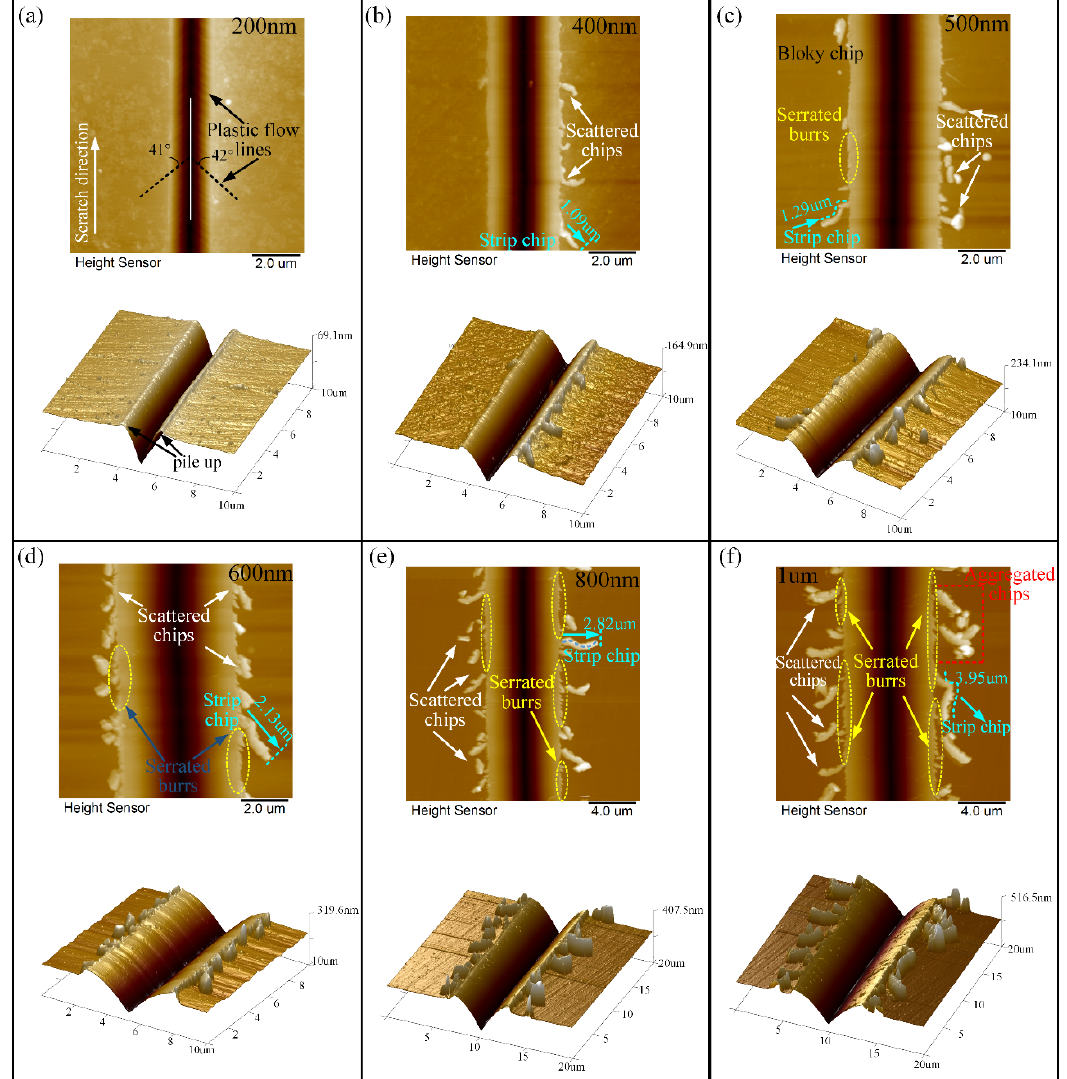
Figure 8. Surface deformation characteristic of edge-forward scratching under different scratch depths: ( a ) 200 nm; ( b ) 400 nm; ( c ) 500 nm; ( d ) 600 nm; ( e ) 800 nm; ( f ) 1 m.